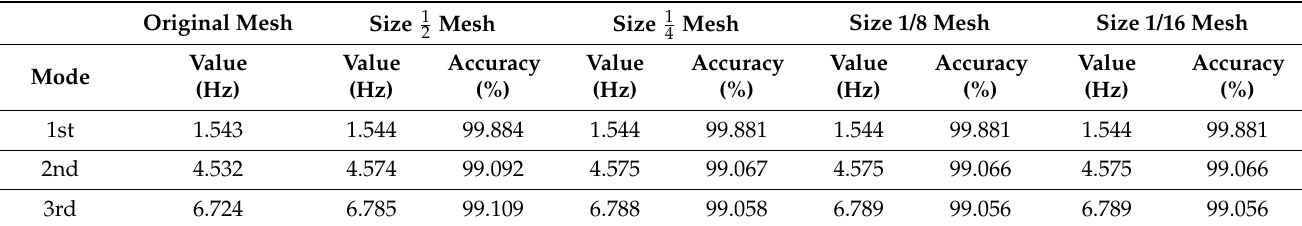
Table 1. Mesh sensitivity analysis result.